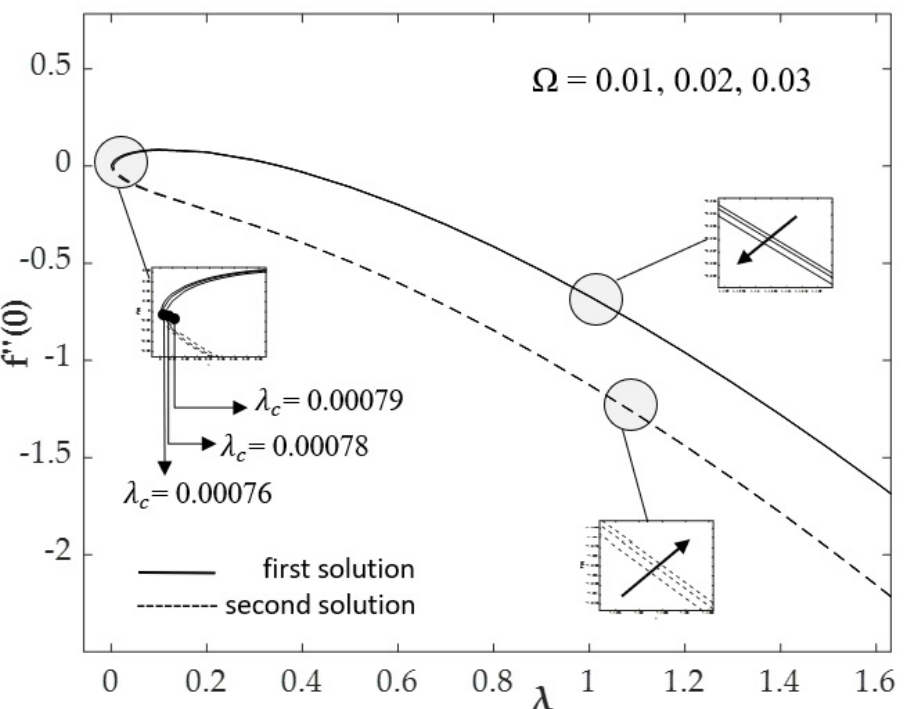
Figure 3. Variations of the skin friction coefficient in the y direction, h (cid:48) ( 0 ) , with stretching parameter λ for various values of φ 2 .